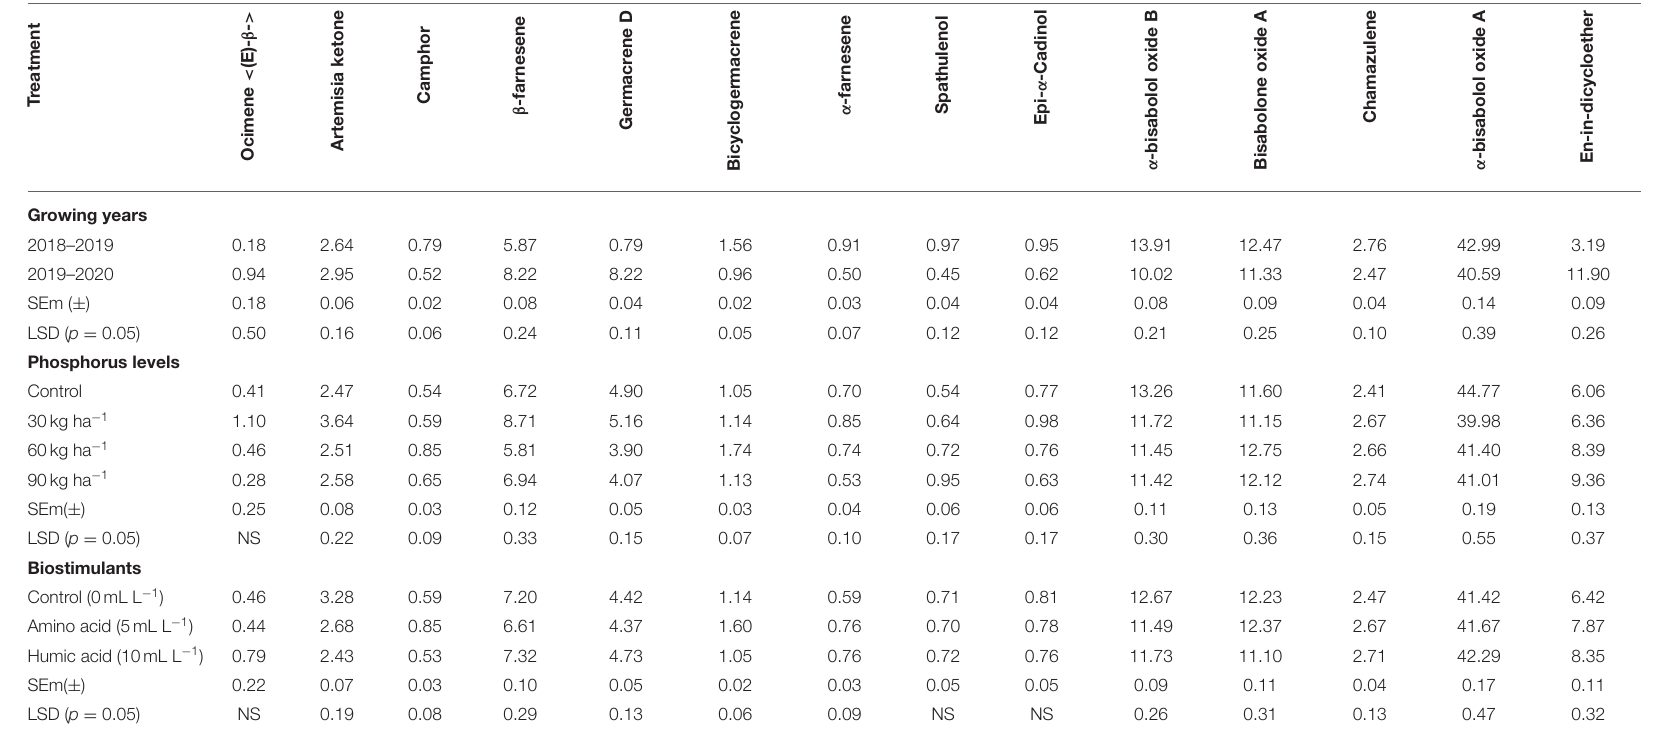
TABLE 4 | Growing years, phosphorus and biostimulant application influences essential oil composition in M. chamomilla . n t e m ea t T r